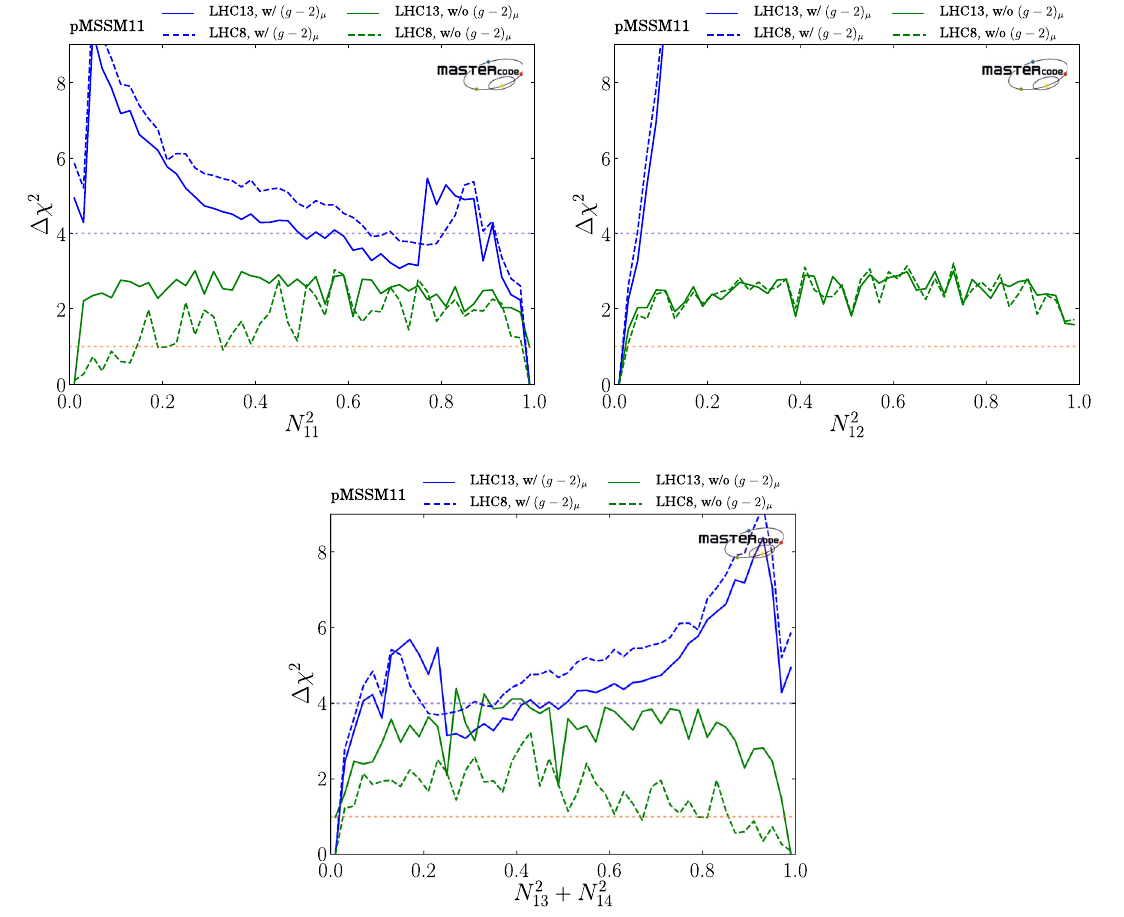
Fig. 12 One-dimensional likelihood plots for the ˜ B fraction in the LSP ˜ χ 0 for the ˜ H u , d fraction (lower